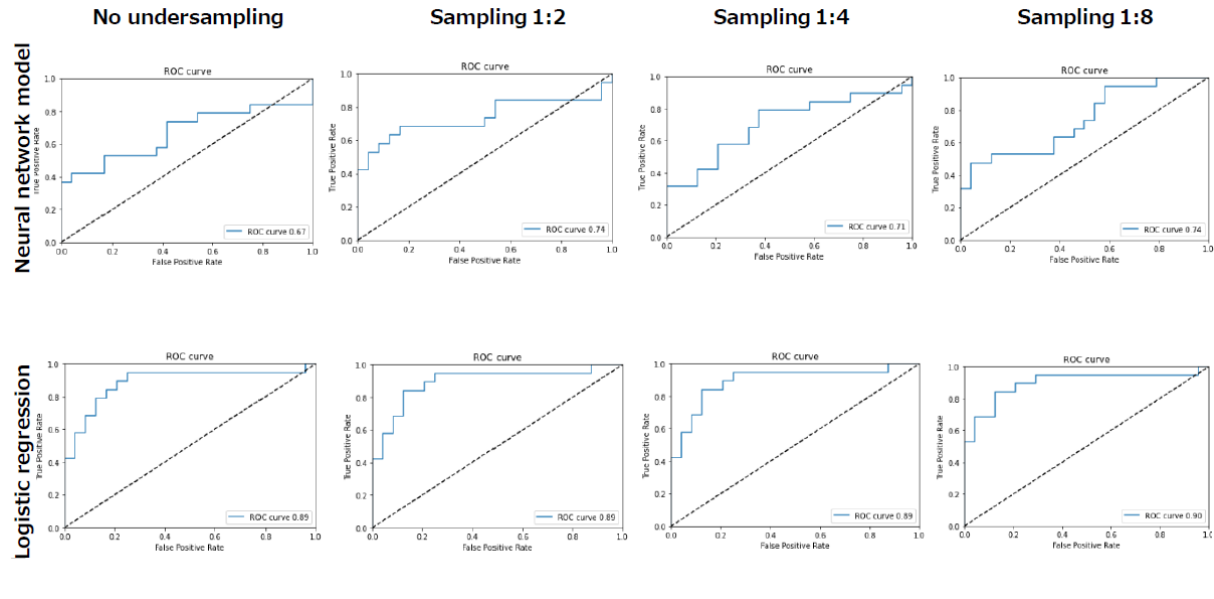
Figure 3. Receiver operating characteristic (ROC) curve of each neural network model and logistic regression for insulin initiation. The areas under the curve of the neural network model (upper row) for no undersampling, sampling ratio of 1:2, sampling ratio of 1:4, and sampling ratio of 1:8 were 0.67, 0.74, 0.71, and 0.74, respectively. For logistic regression (lower row), the areas under the curve for no undersampling, sampling ratio of 1:2, sampling ratio of 1:4, and sampling ratio of 1:8 were 0.89, 0.89, 0.89, and 0.90,